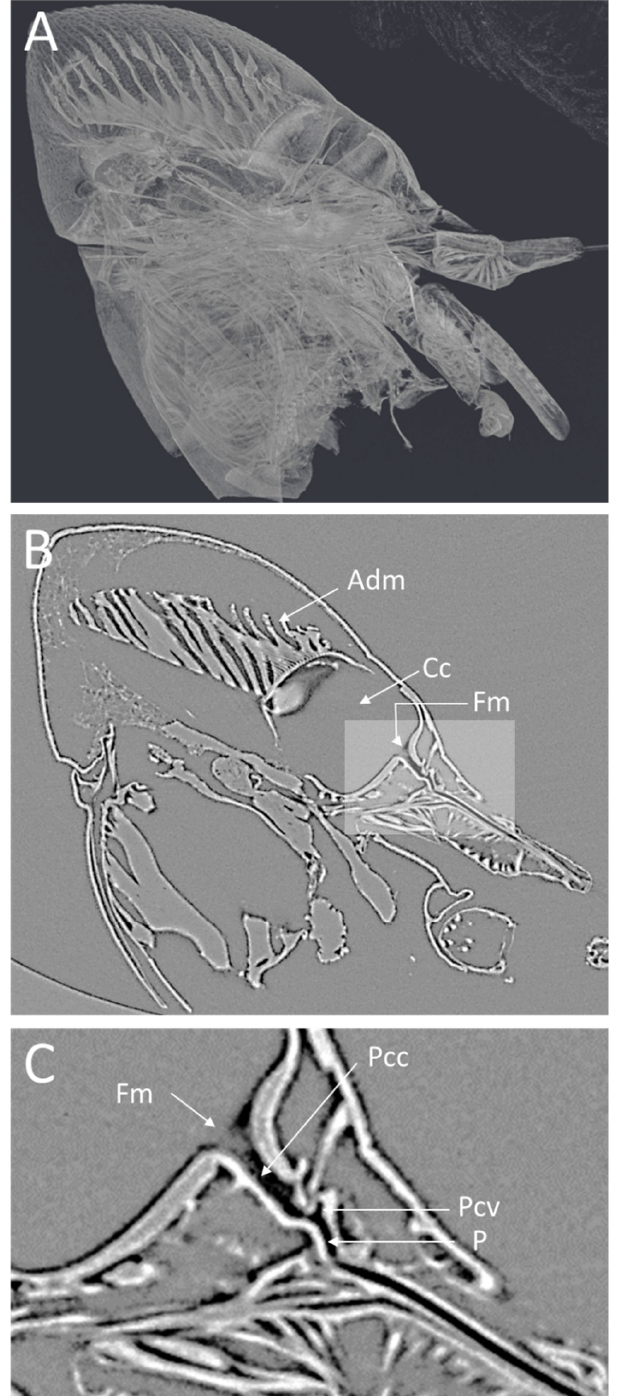
Figure 3. Low-magnification microCT images showing a medial virtual cross-section through the GWSS head. In ( A ), the semitransparent 3D volume rendering shows the whole head and internal structures and musculature. The 2D medial cross-section in ( B ) shows a single virtual slice positioned to bisect the cibarium chamber and the mouthparts where Xylella fastidiosa forms biofilms. A higher magnification view of the foregut ( C ) shows the precibarium, precibarium valve, and other features. Adm, apodeme of dilator muscle; Cc, cibarium chamber; Fm, food meatus; Pcc, precibarium canal; Pcv, precibarium valve; P, precibarial valve’s pit.